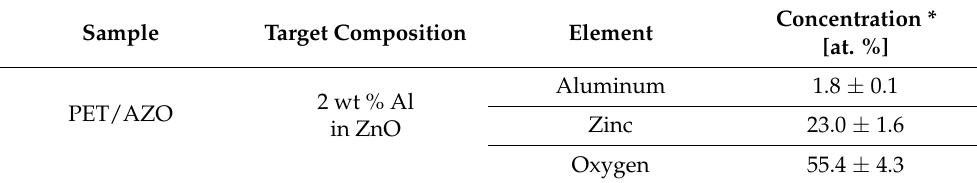
Table 2. Elemental composition of Al-doped ZnO films evaluated by EDX measurement. Sample Target Composition Element